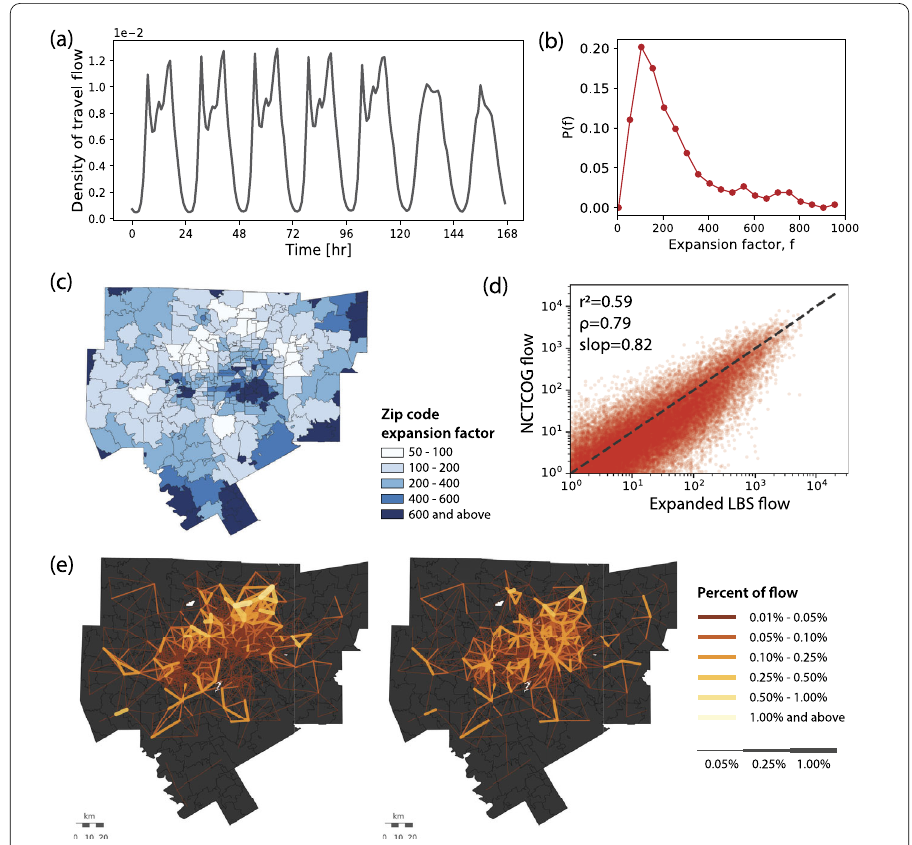
Figure 3 Validation of travel demand generated by LBS data. ( a ) Fraction of travel flow per hour during one week generated by LBS data. ( b ) Distribution of expansion factor at Zip code level. ( c ) Visualization of expansion factor of each Zip code. ( d ) Comparison of vehicular travel flow during the morning peak hours between expanded LBS data and the NCTCOG data. Each red point represents an OD pair at ZIP code level. ( e ) Visualization of vehicular travel flow above 0.01% between ZIP codes during the morning peak hours generated by expanded LBS data (left) and the NCTCOG data